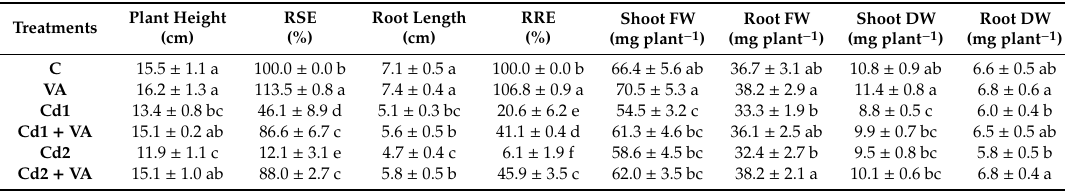
Table 1 . Effects of exogenous VA on plant height, root length, relative elongation of shoot and root, shoot and root fresh weight, and shoot and root dry weight of rice ( Oryza sativa L. cv. BRRI dhan54) seedlings under Cd toxicity stress. C, VA, Cd1, and Cd2 indicate control, vanillic acid (50 µM), CdCl 2 1.0 mM, and CdCl 2 2.0 mM, respectively. RSE and RRE indicate relative elongation of shoot and relative elongation of root, respectively. Means (± SD) were calculated from three replications ( n = 3) for each treatment. Values with different letters are significantly different at p ≤ 0.05 applying Fisher's least significant difference (LSD) test .